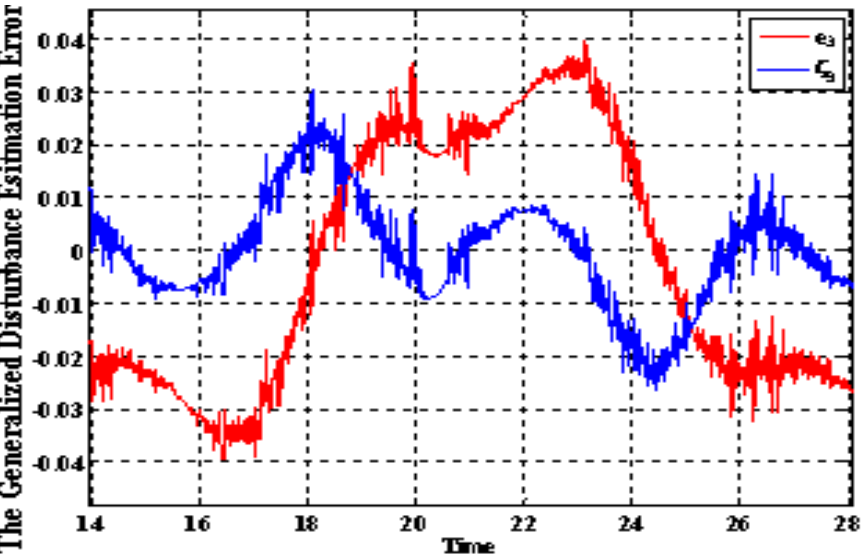
Figure 7. The estimation errors of the generalized disturbances.